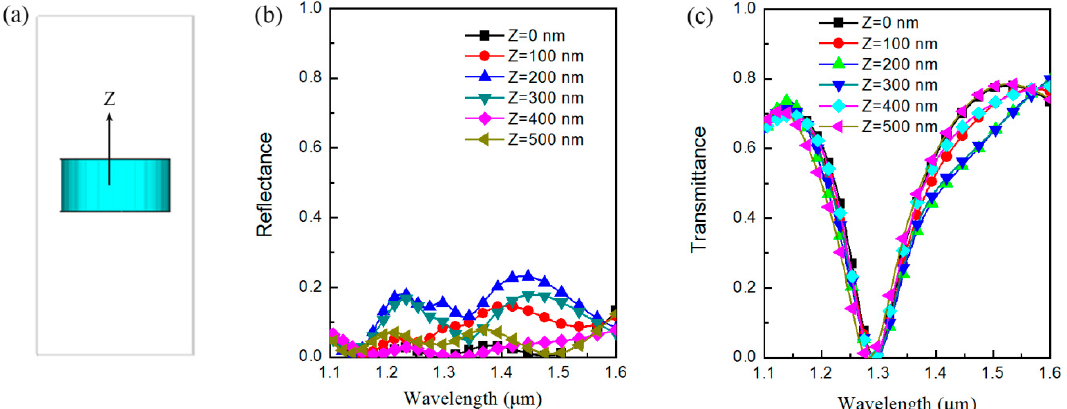
Figure 2. Silicon disk position and its z -direction-dependent reflectance and transmittance characteristics. ( a ) Schematic representation of the silicon disk at the center of the unit cell and the direction of silicon movement. ( b ) Reflectance and ( c ) transmittance characteristics of the unit cell when the silicon disk position varies from z = 0 to z = 500 nm in steps of 100 nm.